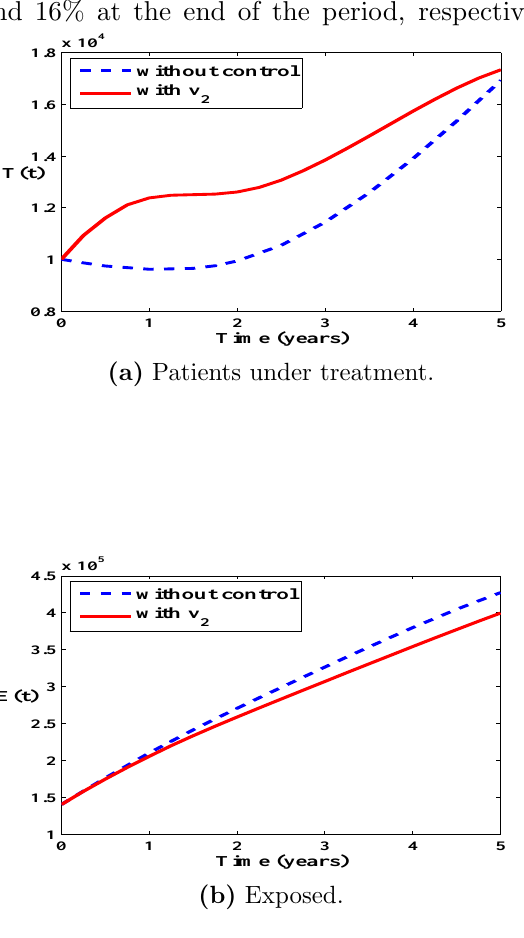
Figure 5. Number of T , E , I and L with control v 2 and without